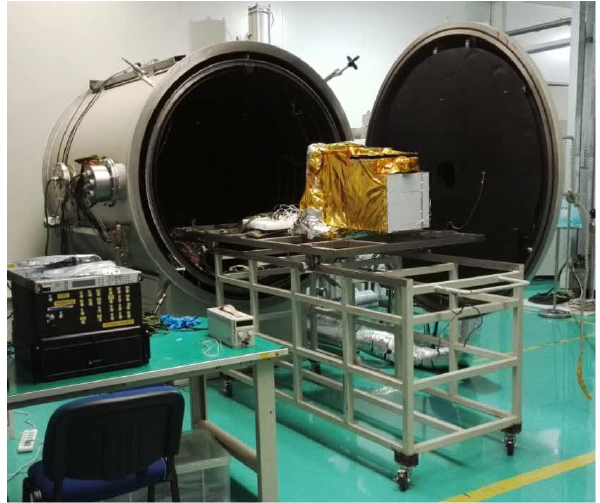
Figure 4. Thermal vacuum test of the